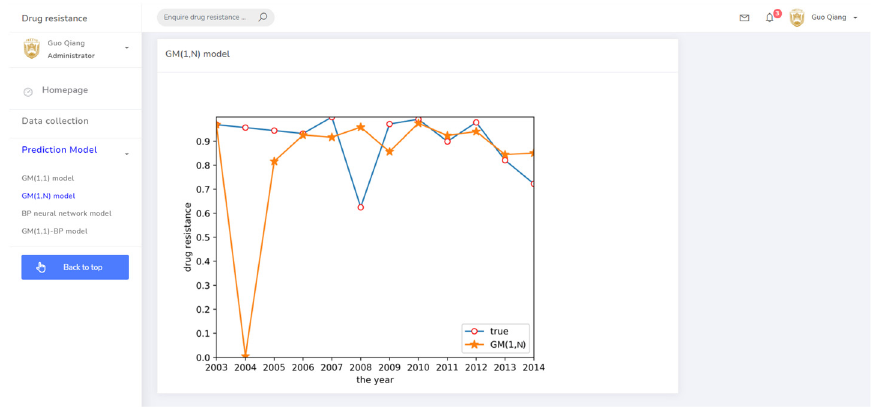
Figure 9. The prediction system page for the GM(1,N) model.